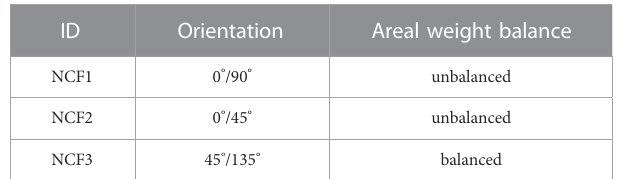
TABLE 2 NCF speci fi